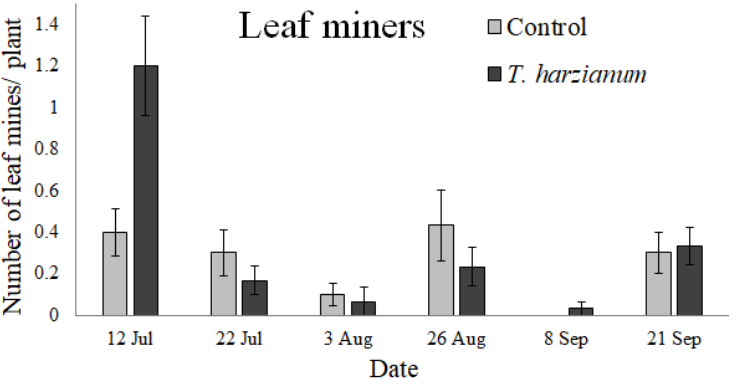
Figure 8. Mean values (± standard errors) of insects that cause leaf mine damage per plant associated with the tomato leaves over time.